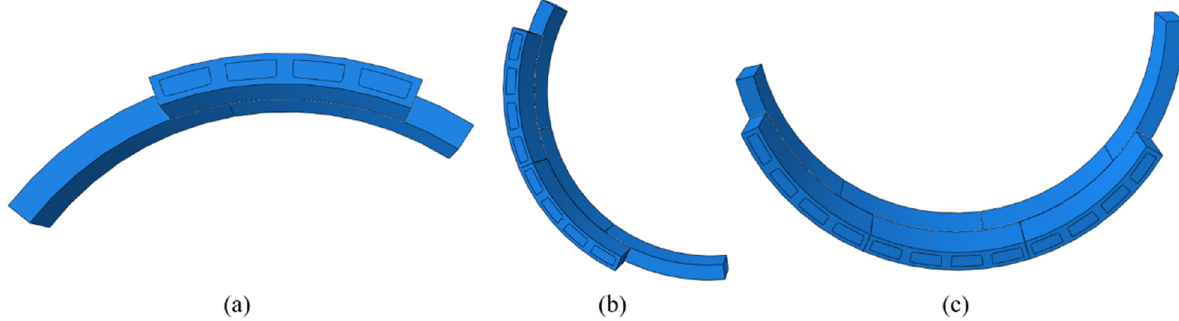
Figure 6. The assembly sequence of segments: ( a ) assembly of the first segment (take the segment at the top as an example); ( b ) assembly of the second segment (take the lateral segment as an example); ( c ) assembly of the third segment (take the segment at the bottom as an example).